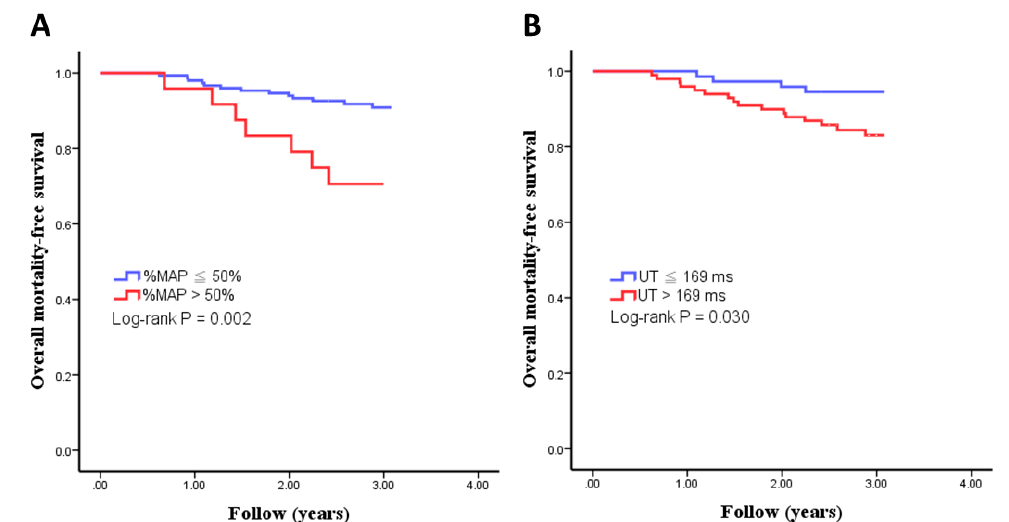
Figure 1. Kaplan–Meier curves for overall mortality-free survival in all study patients subdivided according to %MAP > 50% or not (Figure 1A; log-rank p = 0.002) and UT > 169 ms or not (Figure 1B; log-rank p = 0.030).